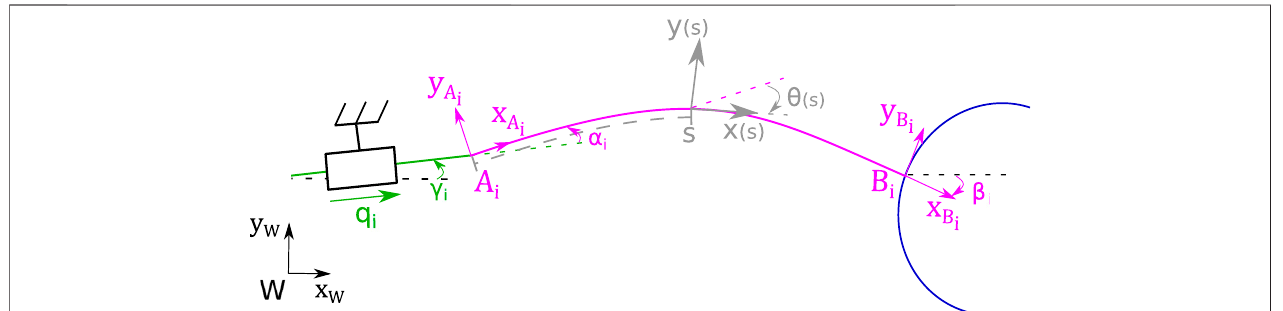
FIGURE 3 | Detailed scheme of the i - th limb with frames and